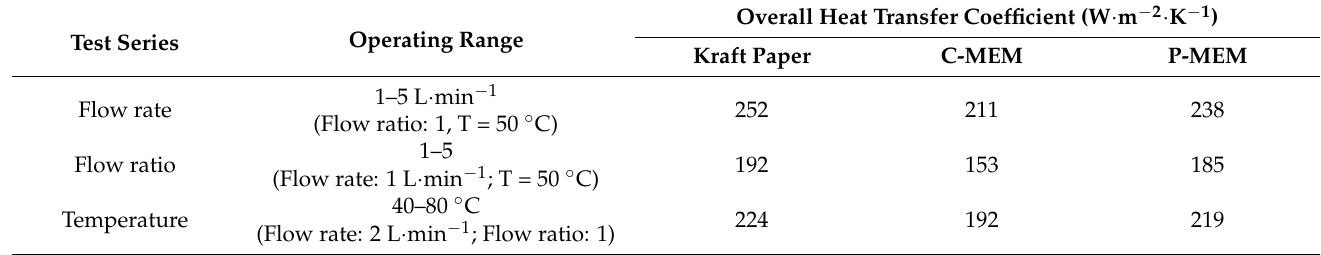
Table 4. The overall heat transfer coefficient (U) of the membrane-based heat exchanger for three different membrane